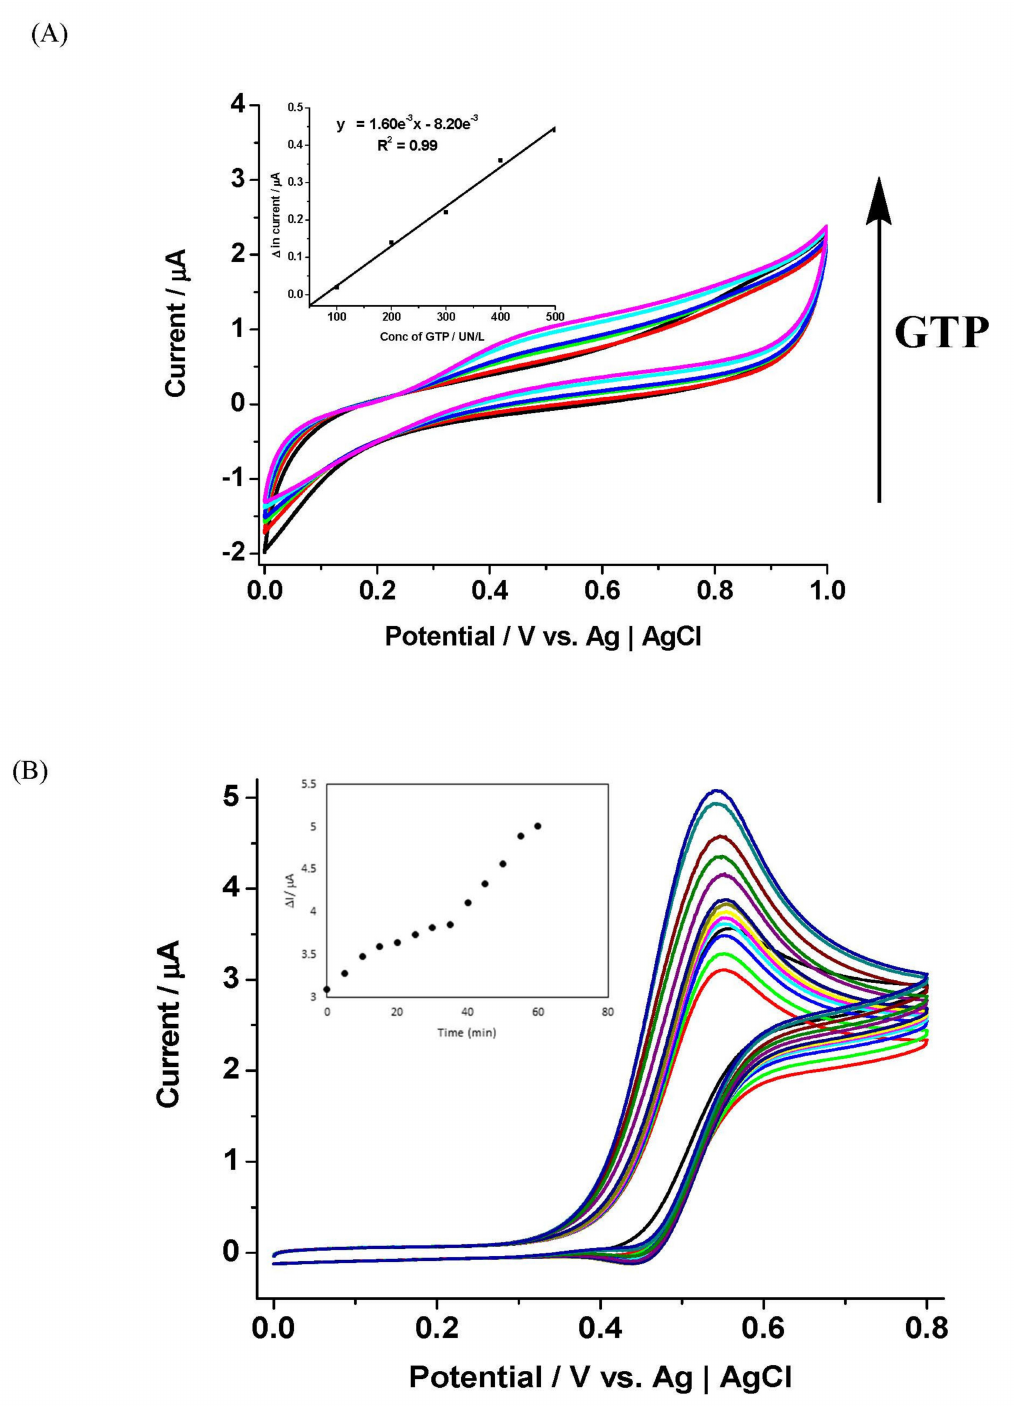
Figure 5. ( A ) Cyclic voltammetry responses of unmediated electrochemical detection towards successive additions of GTP (100–500 U/L) at a GlutOx-modified platinum working electrode. Solution: PBS pH 7.2 (10 mM)-KCl (10 mM) (black curve). Potential sweep, 0–+1.0 V vs. Ag|AgCl, scan rate 10 mV s − 1 . Inset: Calibration data showing a plot of the catalytic current versus GTP concentration. ( B ) Cyclic voltammetry responses of 1-hydroxy-2-[2-(thiophen-3-yl)-ethylamino]ethylferrocene (6) (1 mM) towards addition of GTP (600 U/L). Solution: PBS pH 7.2 (10 mM)-KCl (10 mM), γ - L -glutamyl- L -glutamate (10 mM) and glycyl-glycine (200 mM). Potential sweep, 0–+0.80 V vs. Ag|AgCl, scan rate 10 mV s − 1 . The experiment was conducted by running the mediator CV in substrate solution, followed by addition of GTP and a 5 min incubation. CVs were then run every 5 min for the next 60 min. Inset: plot of catalytic current (I p,ox ) vs. time for the 6-GlutOx electrode response to high activity